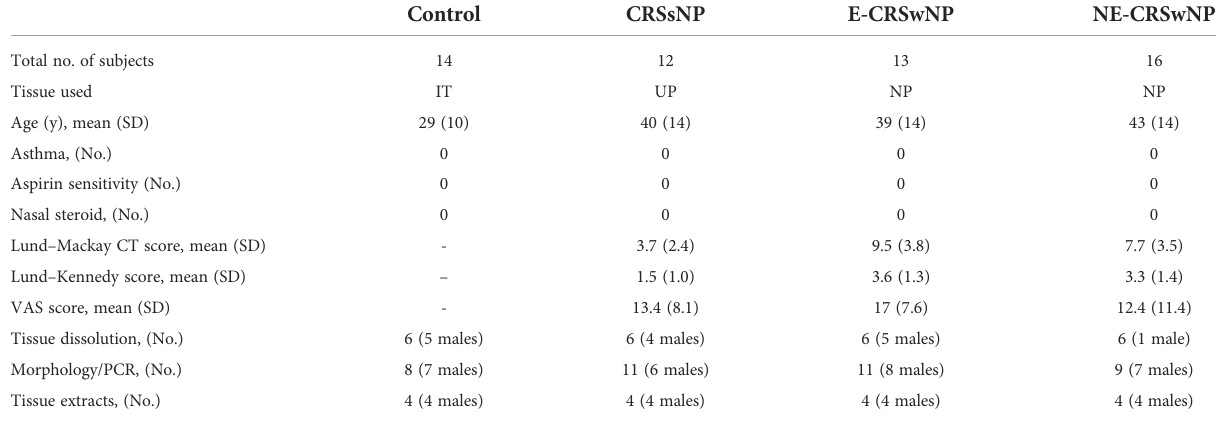
TABLE 1 Characteristics of